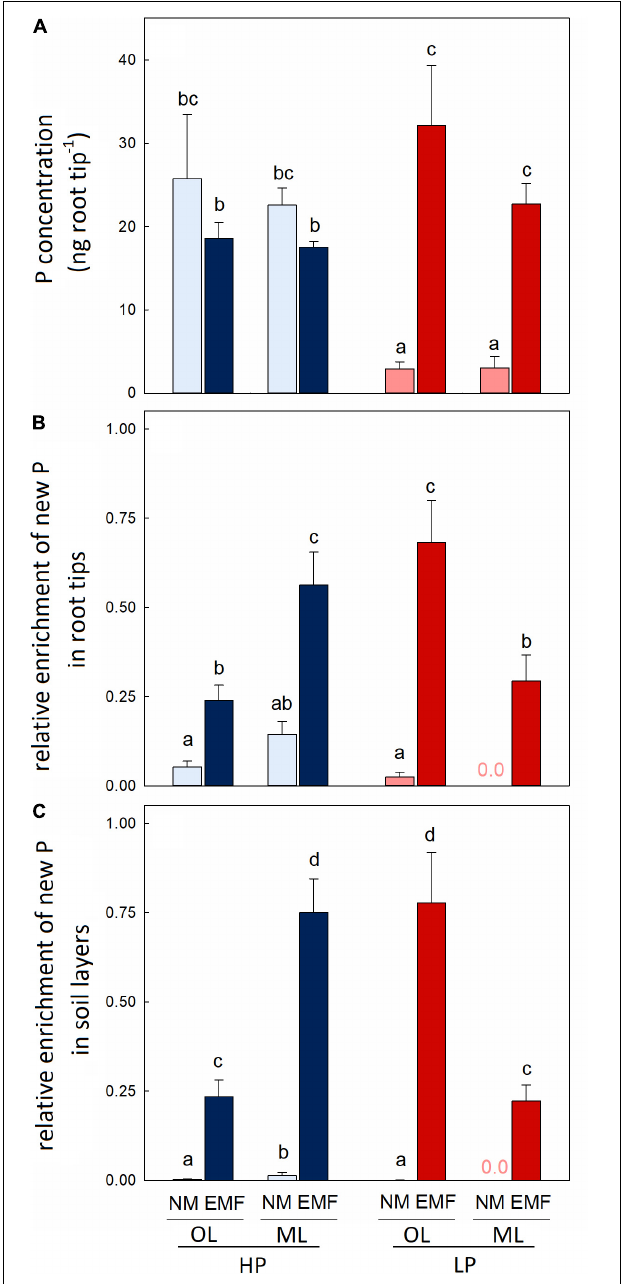
FIGURE 3 | P concentration (A) , relative net enrichment of new P in single root tips of beech trees ( Fagus sylvatica L.) (B) and the relative net enrichment of new P in the sum of mycorrhizal and non-mycorrhizal root tips per forest type and soil layer (C) . Intact soil cores were collected in a P-rich (HP: blue) and a P-poor (LP: red) forest, irrigated with 33 P artificial soil solution and mycorrhizal (EMF) and non-mycorrhizal (NM) root tips from the organic layer (light blue, light red) and the mineral topsoil (dark blue, dark red) were analyzed separately after 24 h of labeling. To determine P enrichment, the rhizospheric 33 P dilutions per forest and layer were used as described under materials and methods. Data indicate means ( n = 5 ± SE). Differences among means per forest and layer were tested by three-way-ANOVA and Tukey HSD post hoc test (A) or by GLM using Poisson distribution (B,C) . Different letters indicate significant differences at p ≤ 0.05.